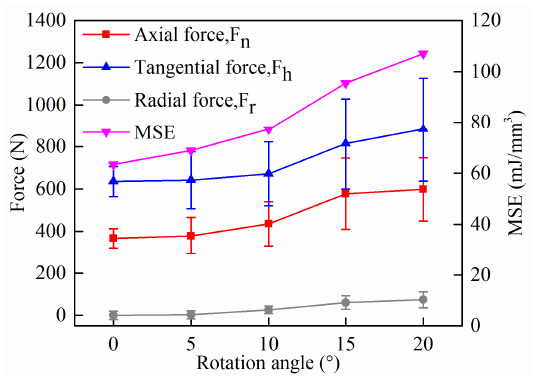
Figure 17. E ff ect of rotation angles on cutting forces and MSE. Figure 17. Effect of rotation angles on cutting forces and MSE.